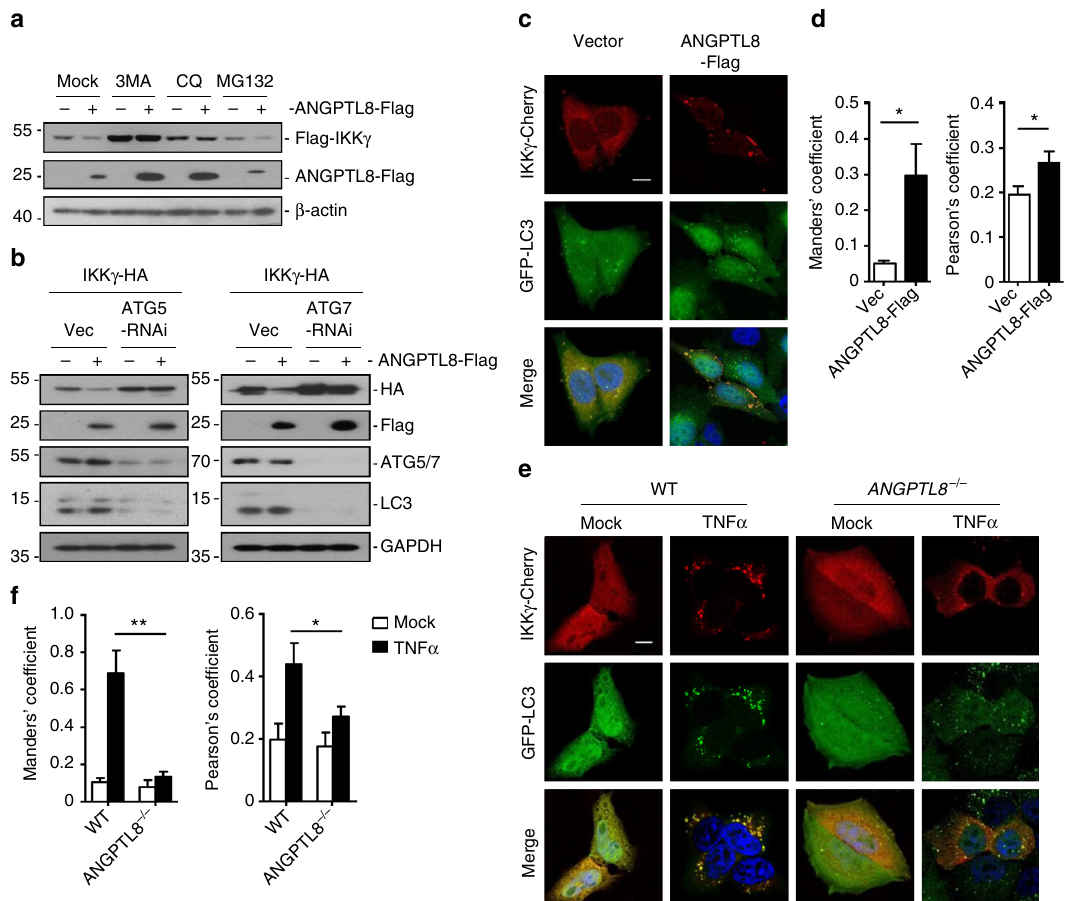
Fig. 6 ANGPTL8 mediates the autophagic IKK γ degradation. a Effects of 3MA, CQ, and MG132 on ANGPTL8-mediated destabilization of IKK γ . HEK293T cells (1 × 10 5 ) were transfected with the indicated plasmids. Fourteen hours after transfection, the cells were treated with the indicated inhibitors (3MA, 3.35 mM; CQ, 0.05 mM; MG132, 10 μ M) for 6 h before immunoblots. b Effects of the knockdown of ATG5/7 on ANGPTL8-mediated IKK γ proteolysis. The HEK293T was transfected with ATG5/7-RNAi for 12 h and followed by puromycin selection (1 μ g/mL) for 12 h before the indicated plasmids were transfected for 24 h, and then cells were collected for immunoblots. c , d The representative images ( c ) of and quantitative results ( d ) of effects of ANGPTL8 on the translocation of IKK γ to autophagosomes, the scale bar represents 10 μ m ( n = 6). e , f The representative images ( e ) and quantitative results ( f ) of effects of ANGPTL8 de fi ciency on TNF α -induced co-localization of IKK γ with the autophagosomes. The scale bar represents 10 μ m ( n = 6). Data are shown as the mean ± SEM, unpaired two-tailed student ’ s test was used for statistics ( d , f ). * p < 0.05, ** p < 0.001. Data